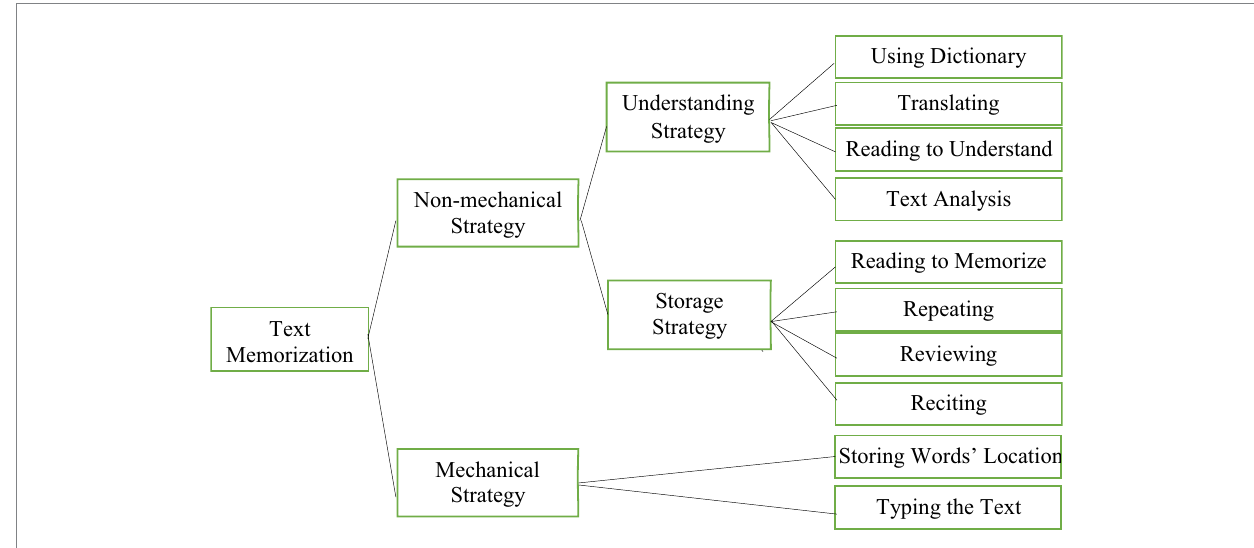
FIGURE 2 Diagram of text memorization strategies used by Chinese EFL learners (source: